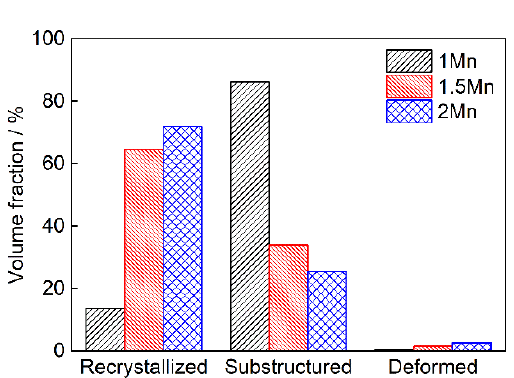
Figure 6. The volume fraction of recrystallization, substructure, and deformation region in ferrite.